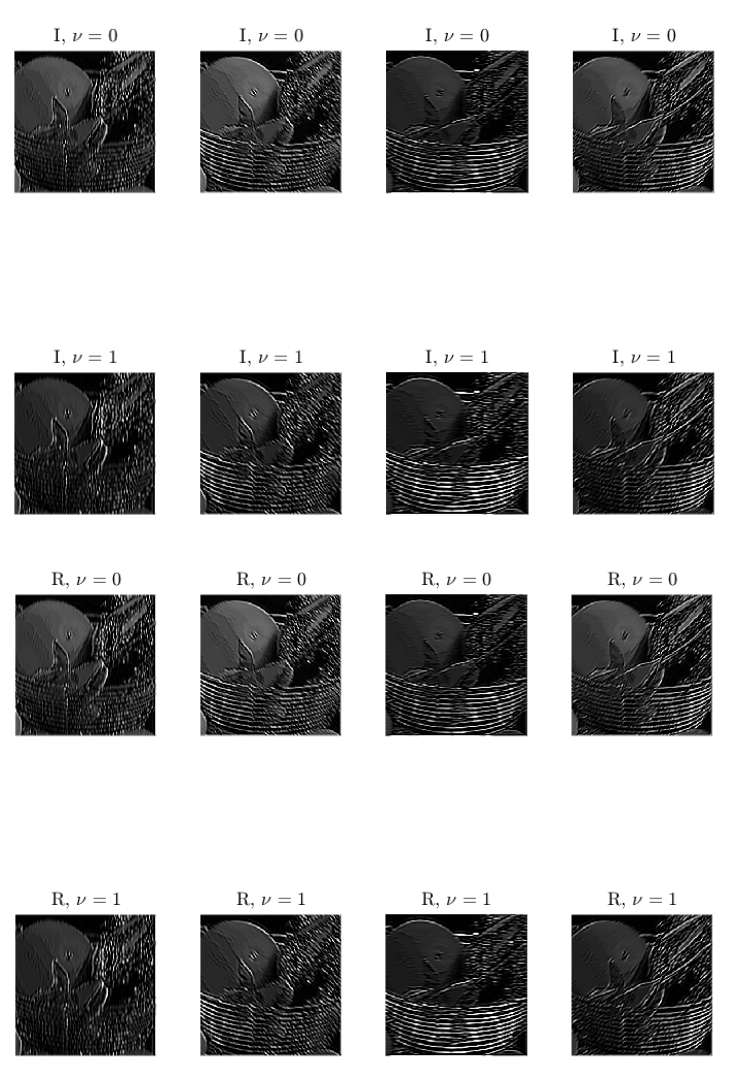
Figure 3. Images obtained by filtering a blurred image by the 16 Gabor filters shown in Figure 2. The original (clean) image is shown in Figure 4.